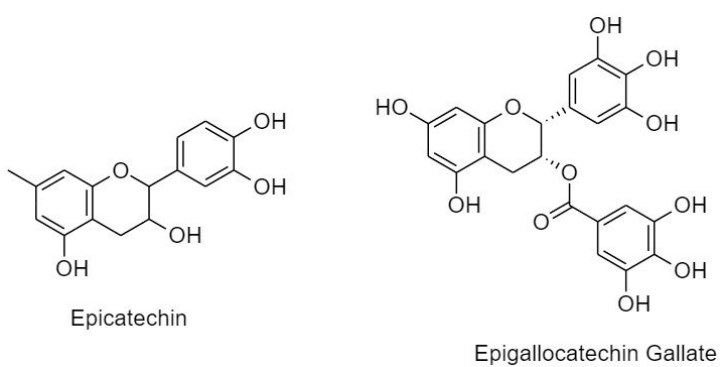
Figure 7. Classification and structure of flavanols.